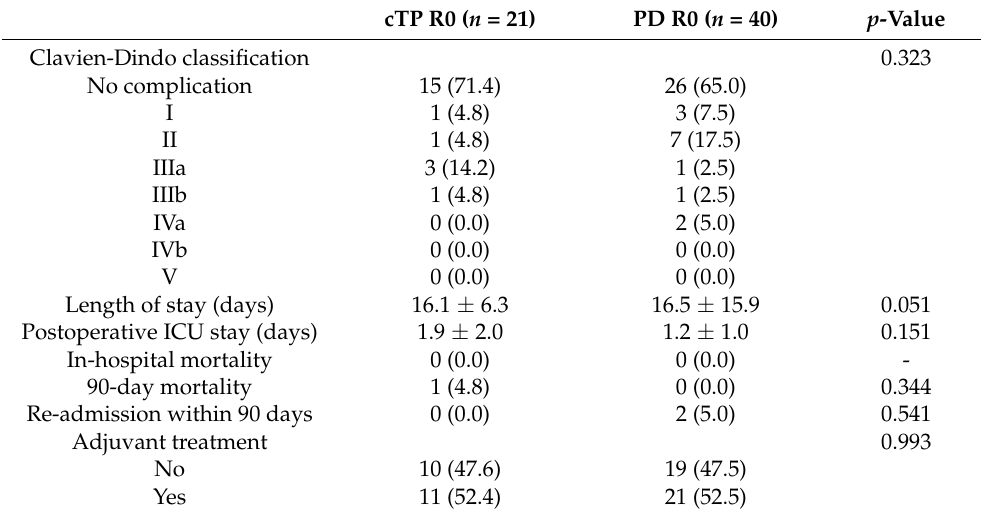
Table 4. Comparison of postoperative outcomes between cTP R0 group and PD R0 group extracted by PSM (number (percent) and mean ± standard deviation).